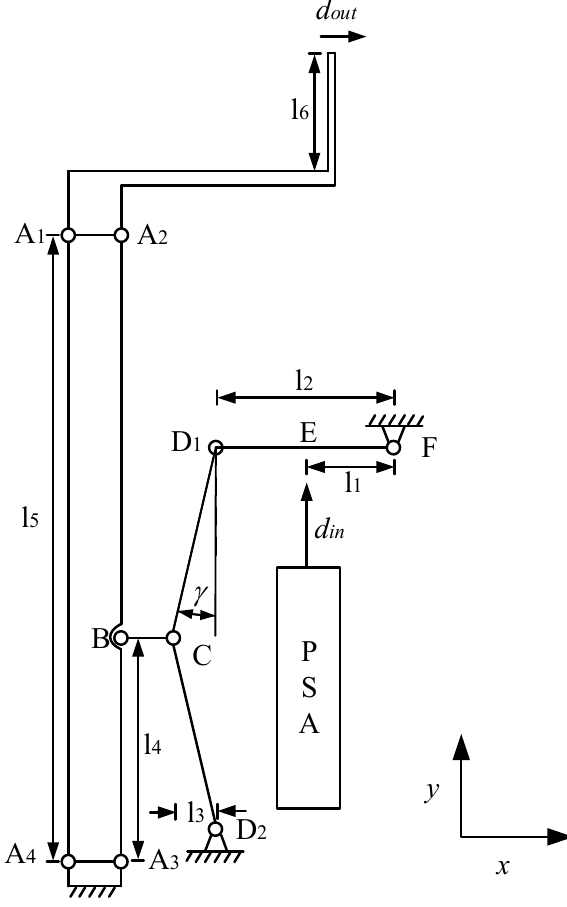
Figure 2. Kinematic diagram of the microgripper.